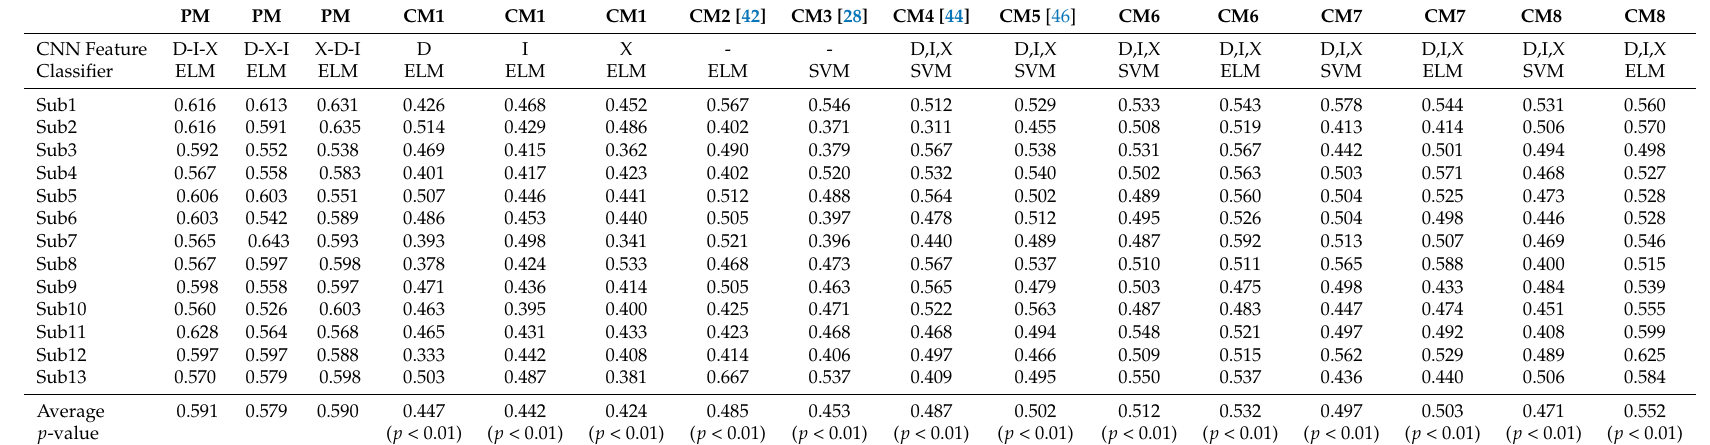
Table 2. Average values of F1-measures of all emotional categories calculated for each subject. Note that • - • - • and • , • , • are different in terms of whether their order is considered or not. p -value was obtained by Welch’s t -test [41].